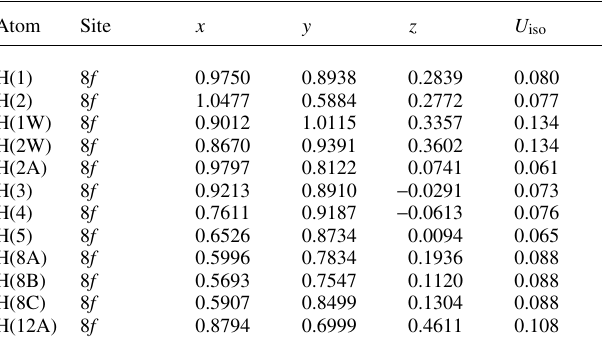
Table 2. Atomic coordinates and displacement parameters (in Å 2 )